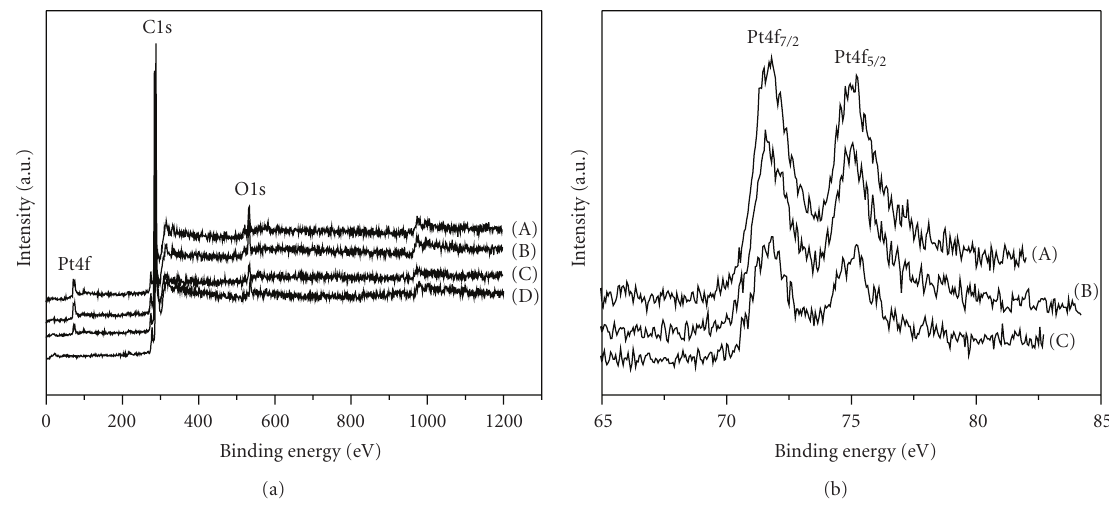
Figure 5: The XPS survey spectra (a) and the Pt4f spectra (b ) for as-prepared MC (D), 0.5-Pt/MC (C), 1-Pt/MC (B), and 2-Pt/MC (A)